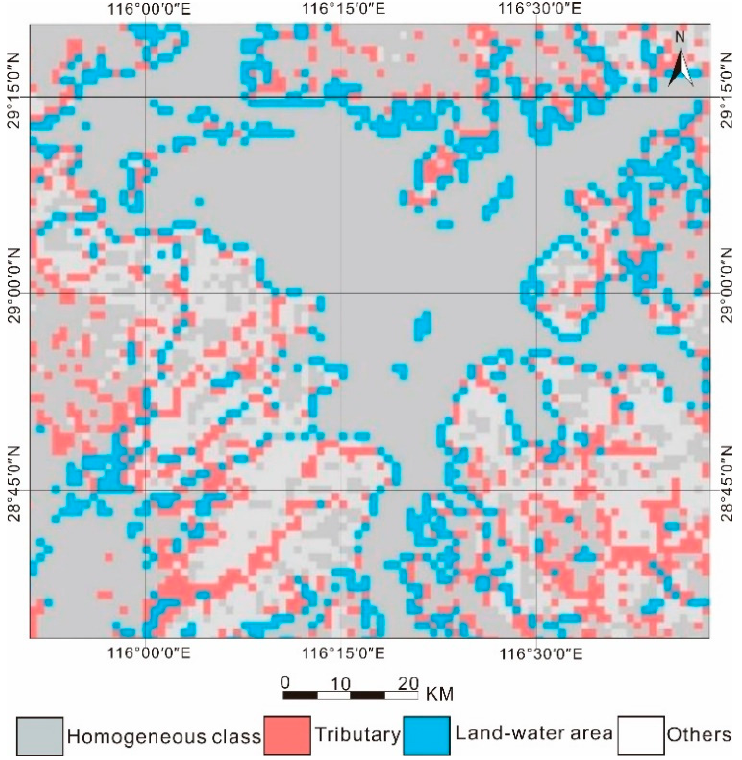
Figure 6. Rough classification result graph of SMDPSO.